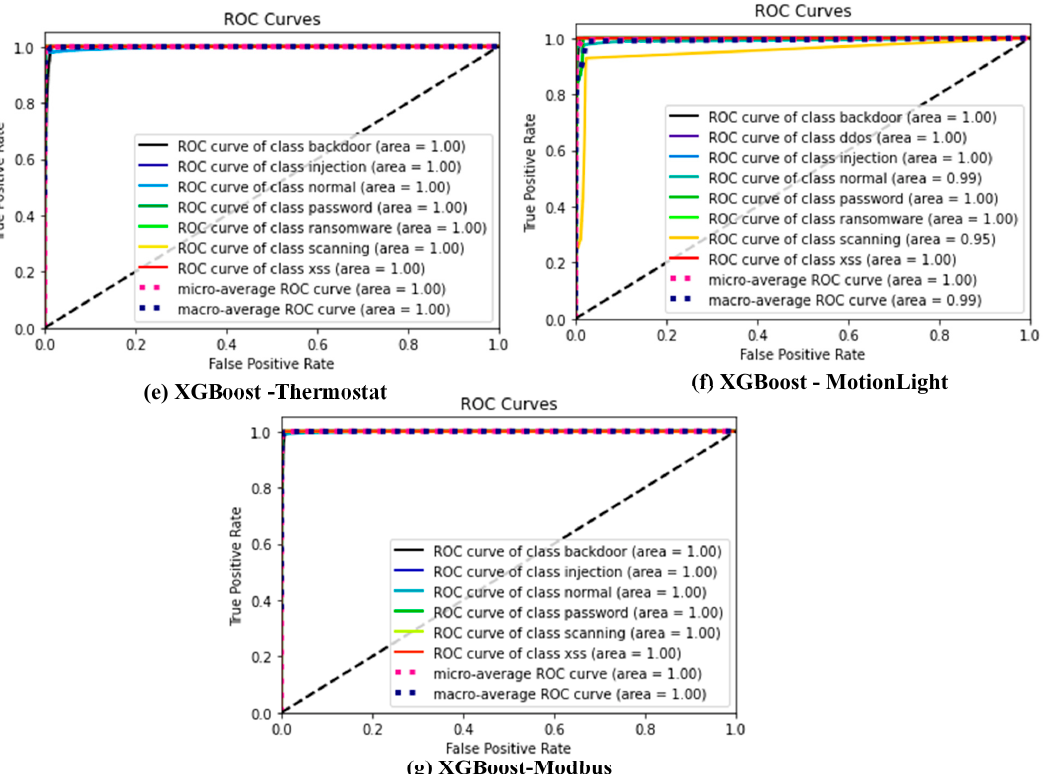
Figure 3. ( a – g ) XGBoost ROC curve for all datasets considered for this study.